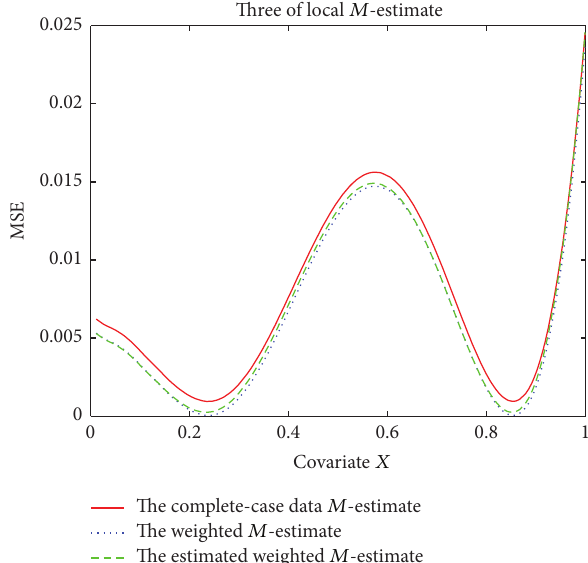
Figure2:ComparisonontheMSEofthree 𝑀 -estimators,wherethe solid curve, the dashed curve, and the dot curve denote the MSE of ̂𝑚 (𝑥) , ̂𝑚 ∗ (𝑥) , and ̂𝑚 ∗ (𝑥) , respectively. 𝑀𝑐𝑐 𝑀 𝑀𝑐𝑝